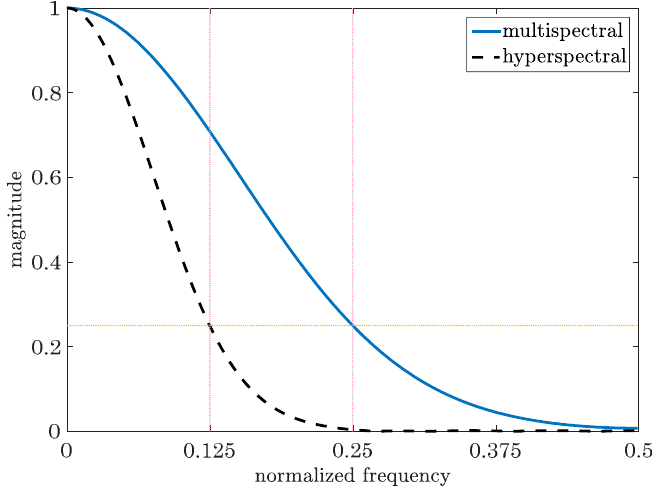
Figure 2. The modulation transfer function (normalized spatial-frequency response) of the used 2D Gaussian blur filters in both spatial dimensions. The solid curve corresponds to the filter used to generate the multispectral images and the dashed curve corresponds to the filter used to generate the hyperspectral